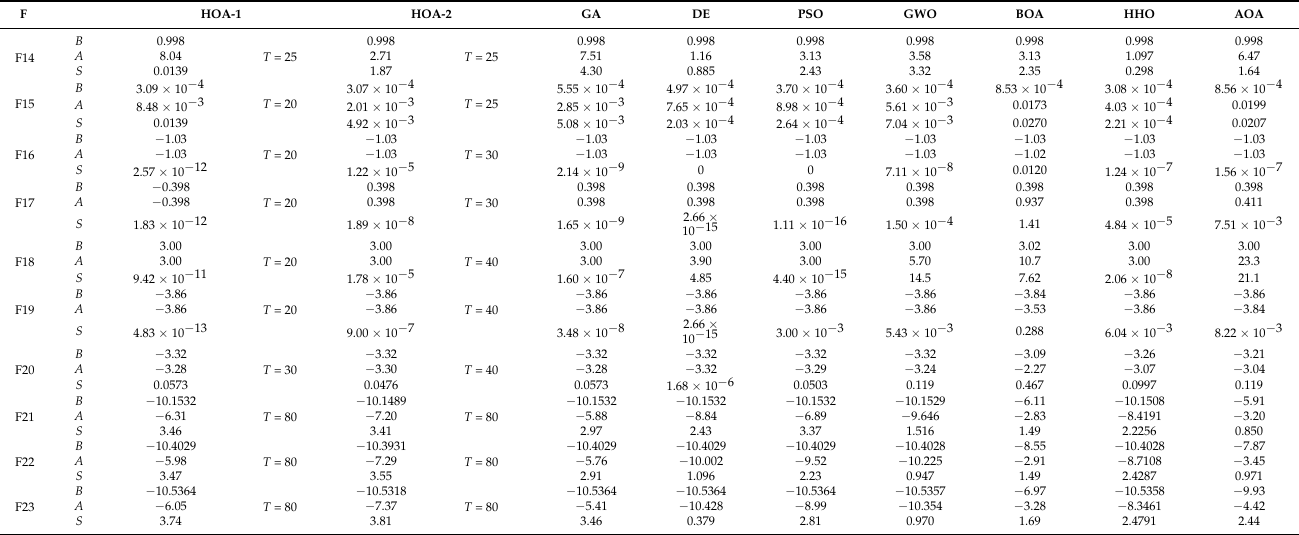
Table 4. Results of fixed-dimension multimodal benchmark functions.